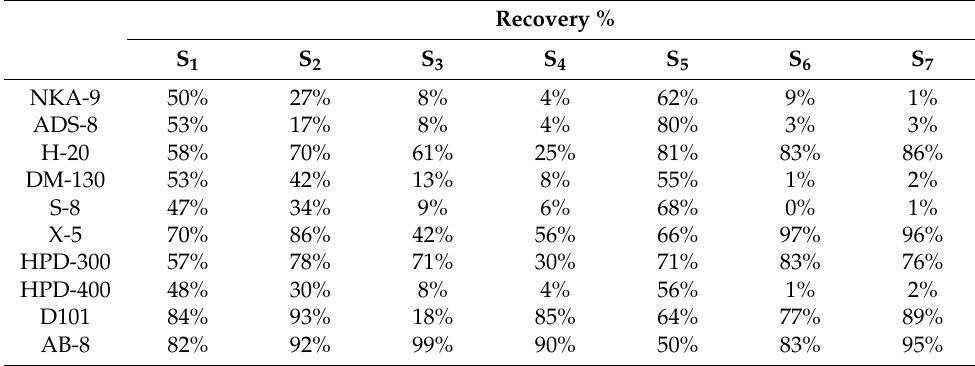
Table 1. The recoveries of Astragalus saponins among different macroporous resins.